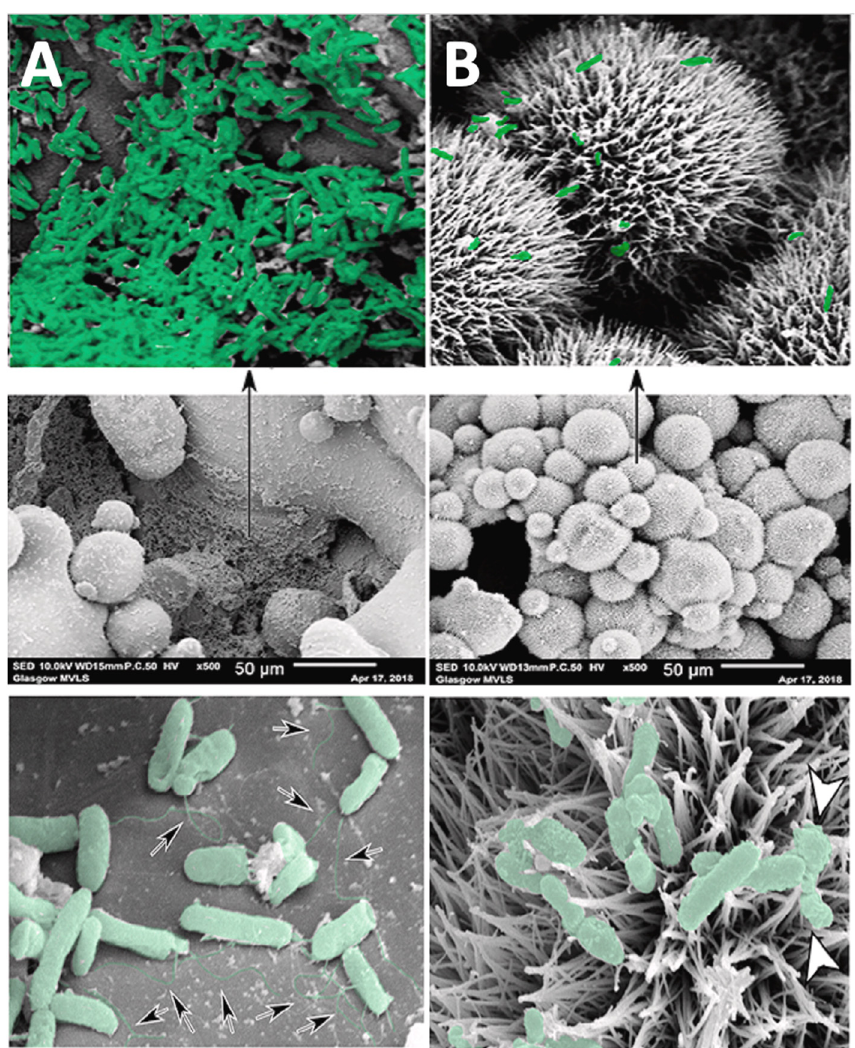
Figure 7. SEM of P. aeruginosa response to the ( A ) D900 uncoated flat control (top, middle rows). Flagella were observed on the control samples (arrows) (bottom row in column A ). ( B ) P. aeruginosa response to the 90 s pPEA-2 hr fibronectin (FN), bone morphogenetic protein-2 (BMP2)-coated D900 surface (top, middle rows, column B ). Flagella were absent in bacterial cells observed on 90 s pPEA-2 hr FN/BMP2-coated D900, with ruptured bacterial cells also observed on the nanowires (arrowheads). In the control uncoated samples, large areas of confluent biofilms were observed in contrast to small, more diffuse bacterial accumulation on the nanowire-coated samples. Modified and reproduced with permission from [234].